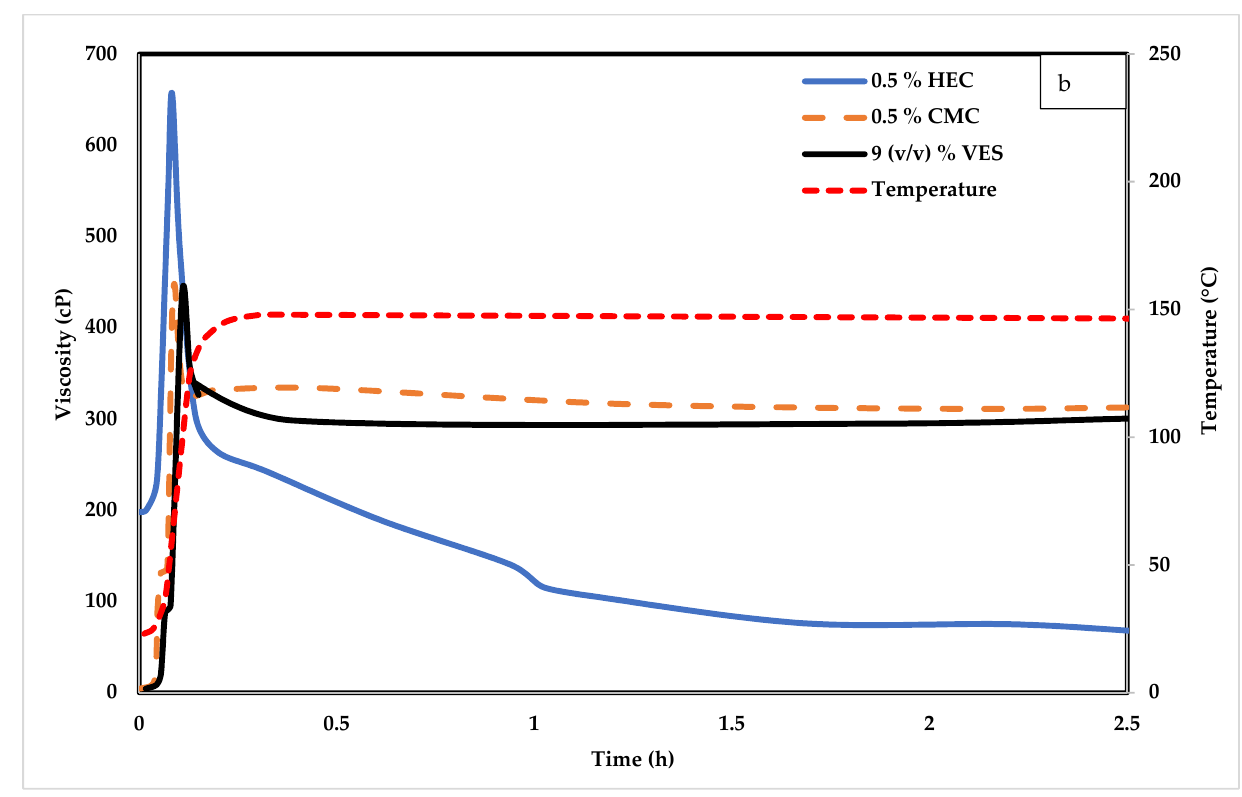
Figure 9. CMC and HEC effect on VES at ( a ) 200 ° F and ( b ) 300 ° F.